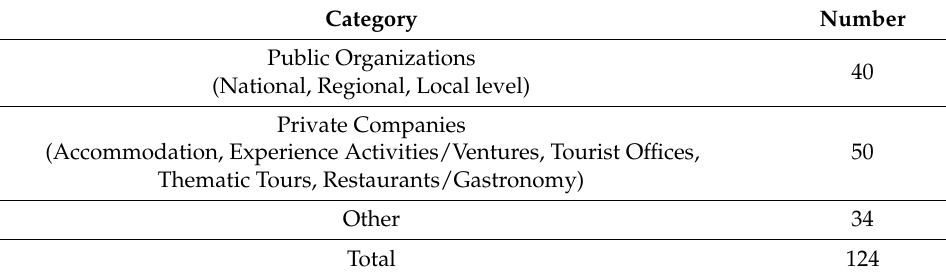
Table 1. Number of potentially relevant stakeholders per